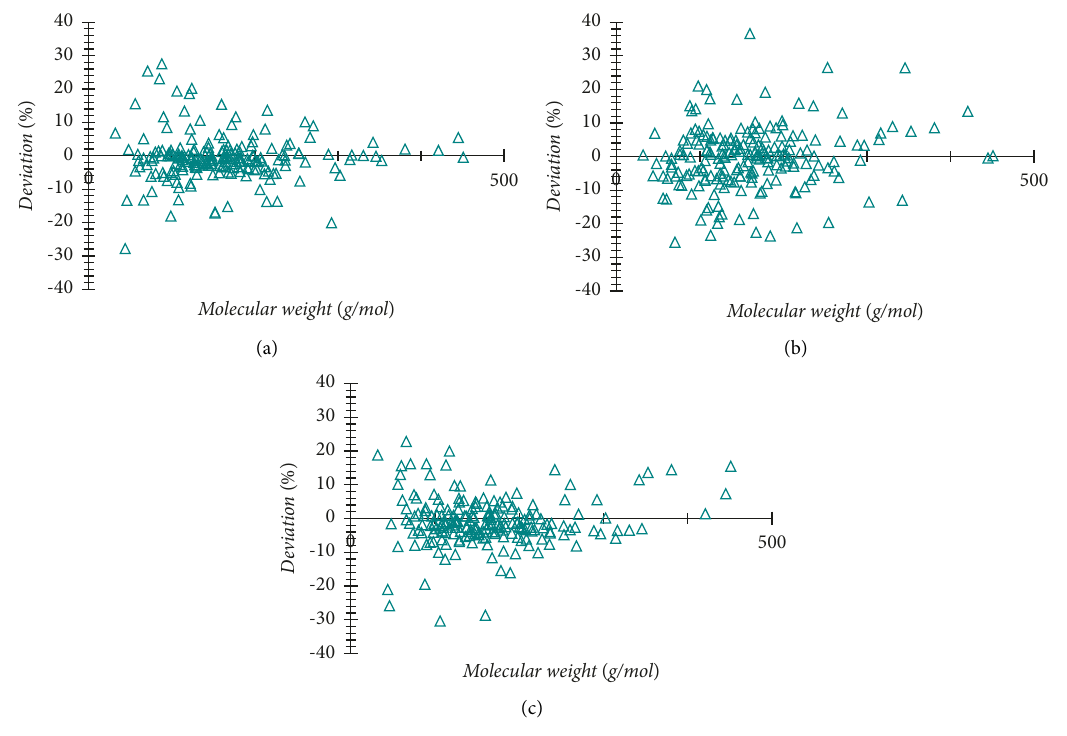
Figure 11: Deviations between the calculations of MTC4, MPC4, and MVC4 models and the model proposed by Gharagheizi et al. [6]. (a) Critical temperature, (b) critical pressure, and (c) critical